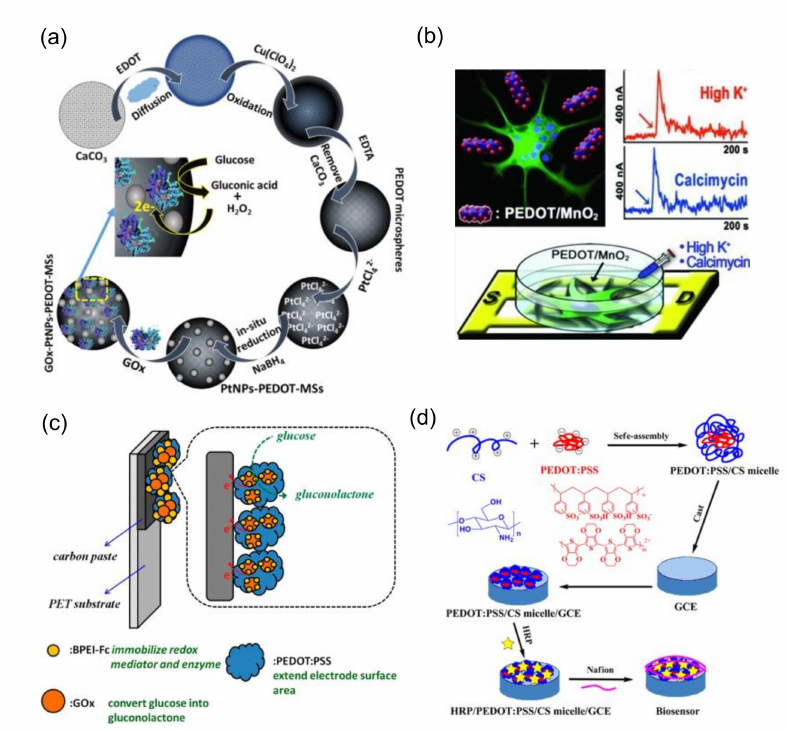
Figure 8. ( a ) Pt nanoparticle-decorated–PEDOT microspheres using CaCo 3 sphere